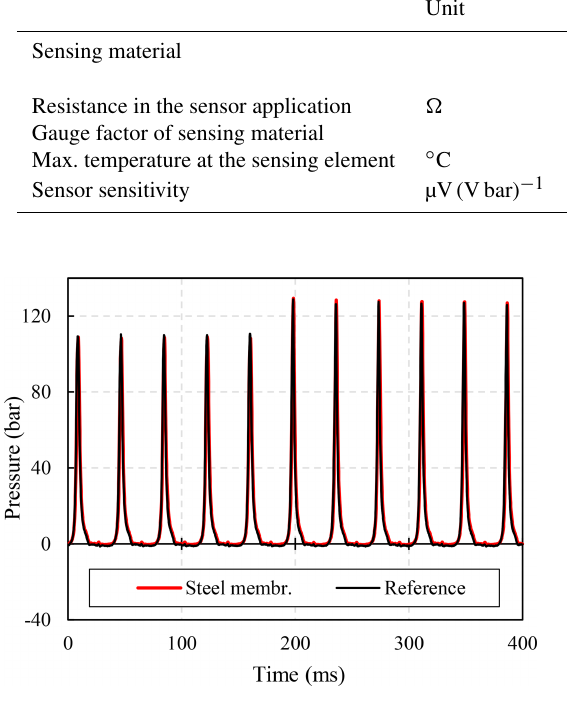
Figure 9. Chronological sequence of several combustion cycles measured with the steel membrane prototype sensor and the ref- erence pressure sensor. At a constant rotation speed of 3200rpm of the diesel engine, the torque was increased from 150 to 200Nm in this cut-out